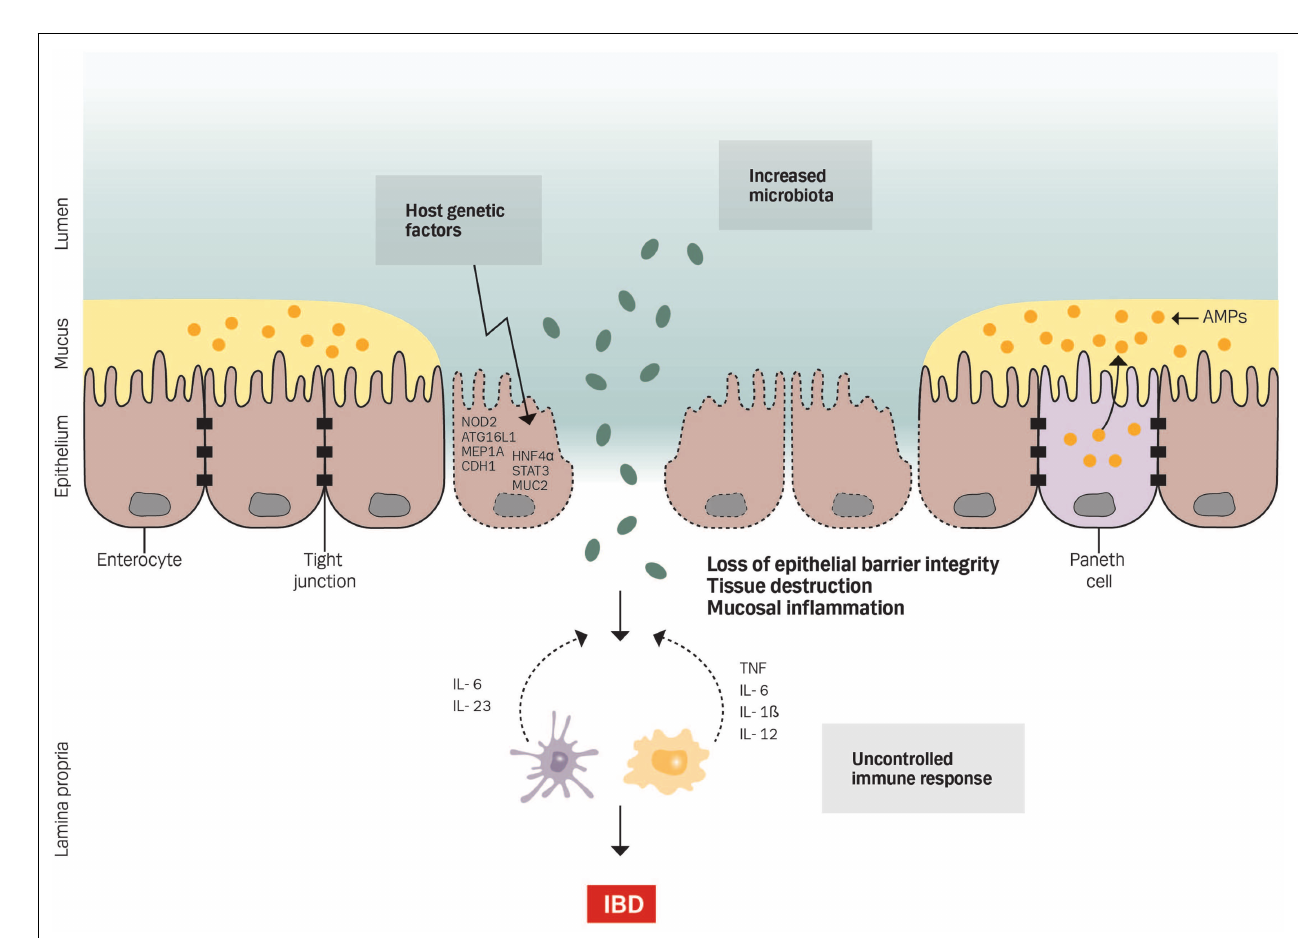
available models, namely, SAMP1/YitFc and C3H/HeJBir,